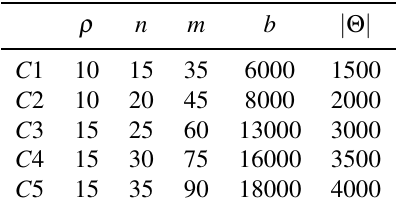
Table 3. Values of ρ , n , m , b and | Θ | for the example cases ρ n m b | Θ |